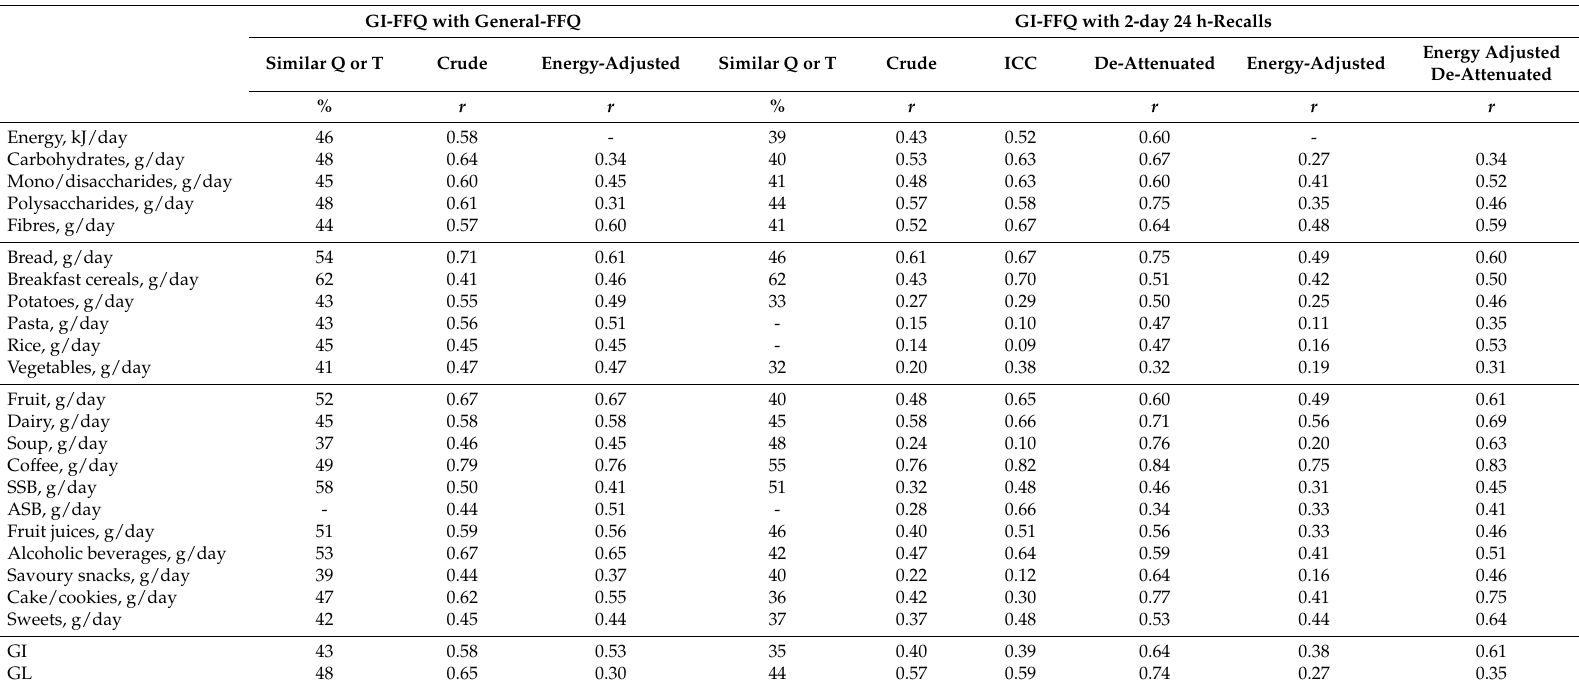
Table 3. Validation results of the glycaemic index FFQ (GI-FFQ) with the general-FFQ and 2-day 24